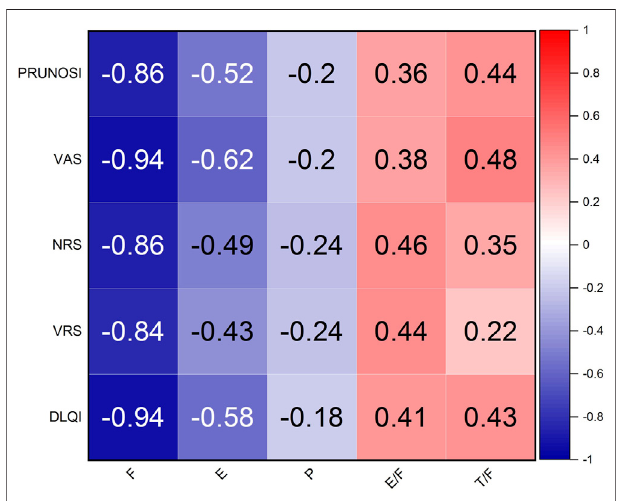
FIGURE 3 | Spearman ’ s correlation coef fi cients between the fi ve scale scores, the levels of steroids and their ratio in plasma in patients with PN ( n =